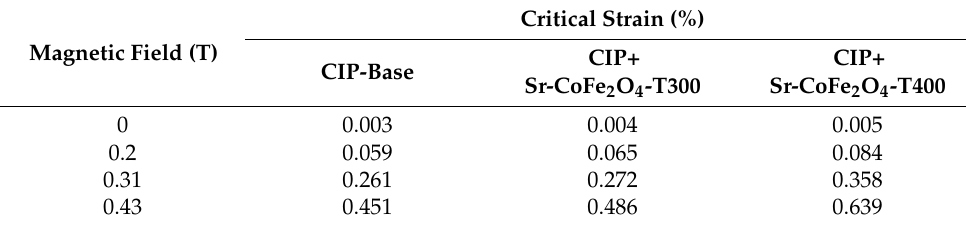
Table 4. The critical strain of MRF